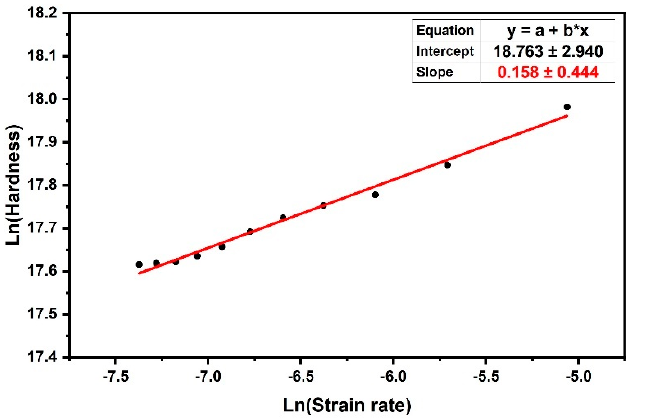
Figure 7. The logarithm of hardness plotted versus the logarithm of strain rate for 51 creep nanoindentation tests on HDPE, for which the value of strain-rate sensitivity was m = 0.158 ± 0.001. The value of the activation volume obtained by this plot was 0.92 (nm) 3 .